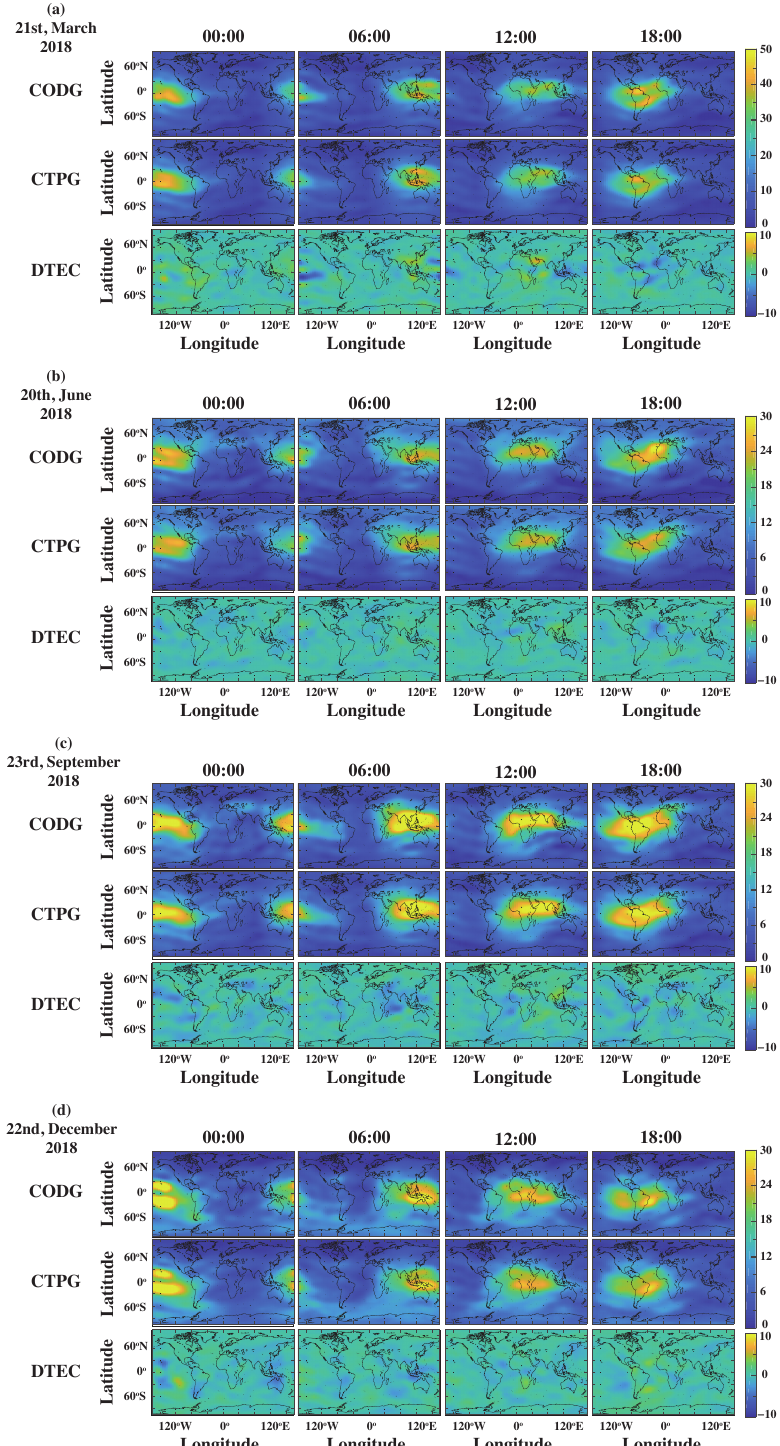
Figure 10. Comparison between the CTPG TEC maps and the CODE TEC maps at 00:00, 06:00, 12:00 and 18:00 UT on ( a ) 21 March 2018, ( b ) 20 June 2018, ( c ) 23 September 2018 and ( d ) 22 December